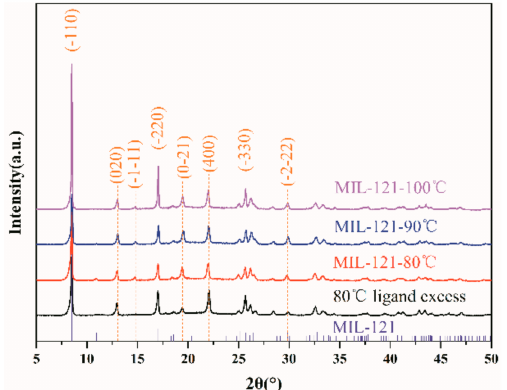
Figure 1. PXRD patterns of MIL-121-ligand excess, MIL-121-80 ◦ C, MIL-121-90 ◦ C, MIL-121-100 ◦